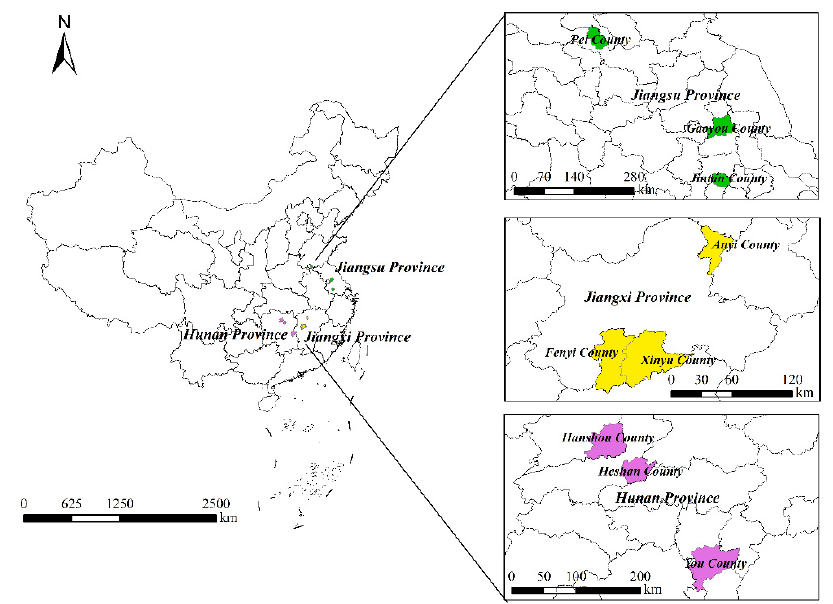
Figure 2. Distribution map of the sample area.